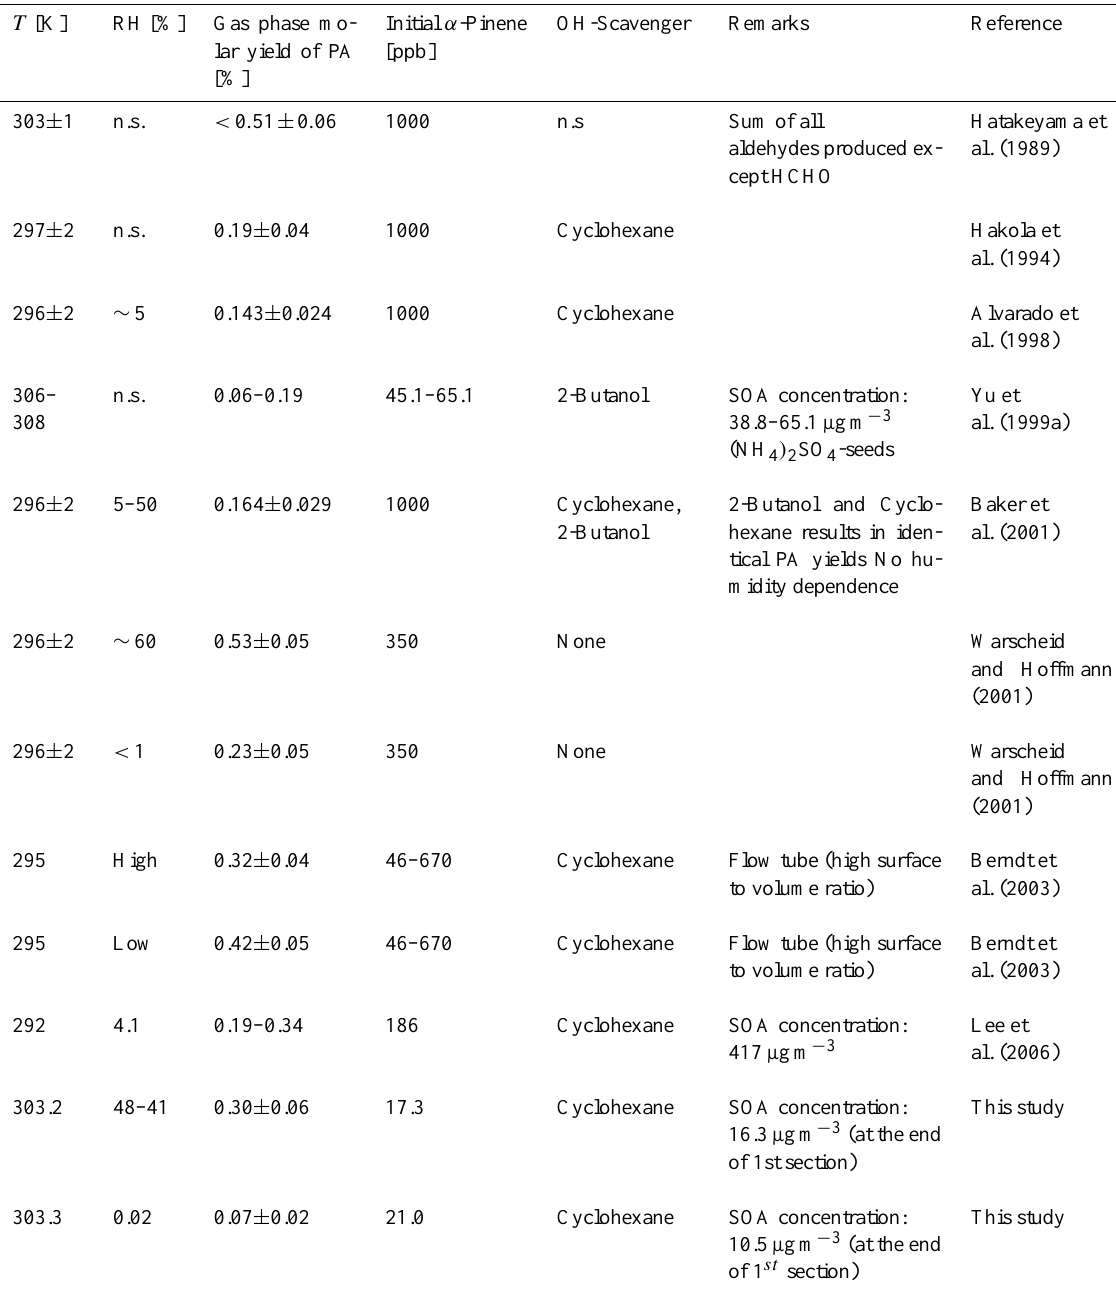
Table 3. Molar pinonaldehyde yields from the ozonolysis of α -pinene compared to other